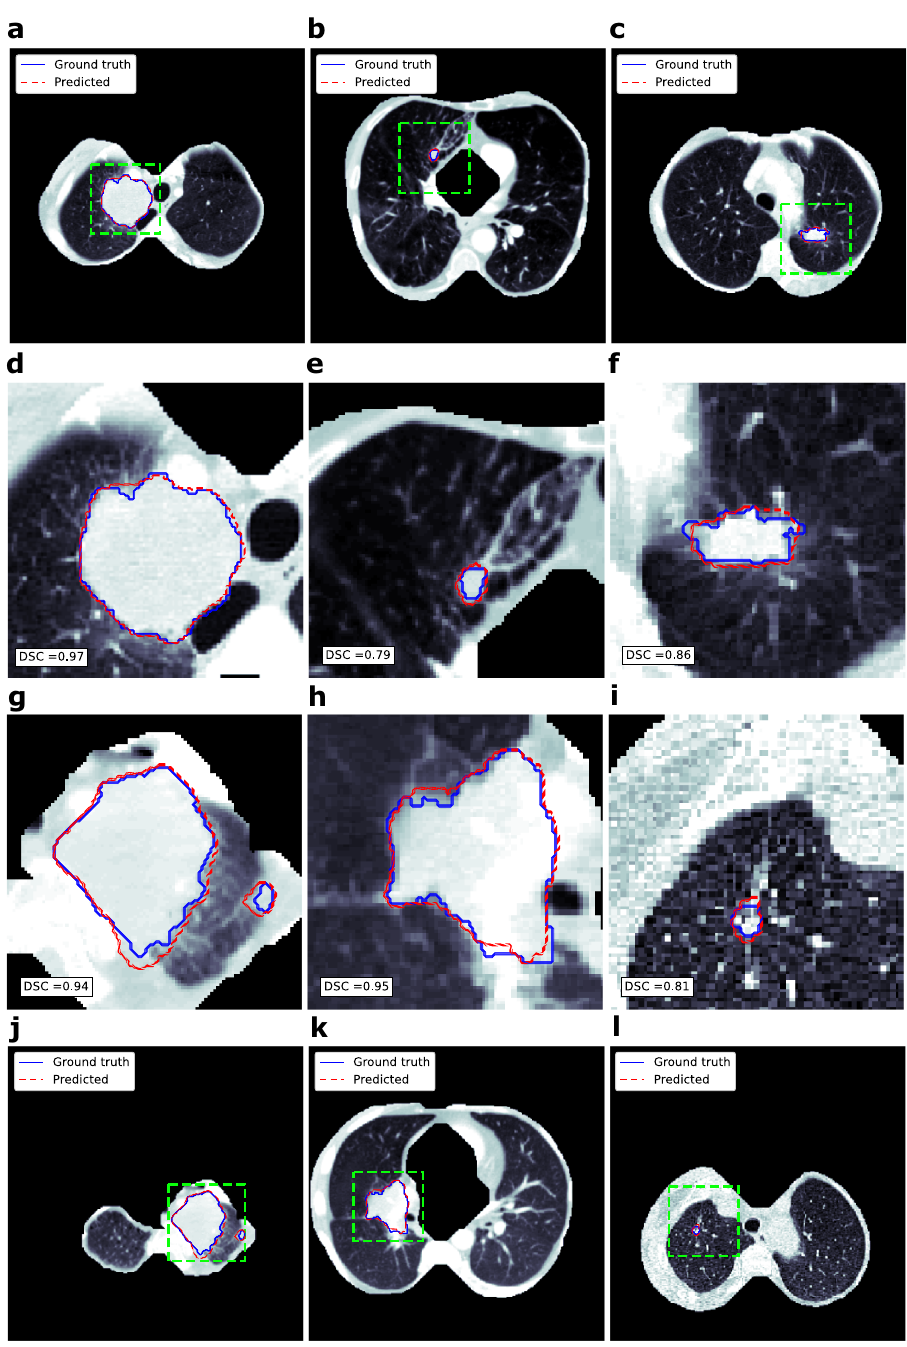
Fig. 3 Visualization of segmentations. Automatically generated tumor segmentations are shown as red lines while manual segmentations are shown in blue, the green dashed box shows the area to be magni fi ed for better visuals. d – i display magni fi ed area for the ( a – c , j – l ) respectively. Corresponding 2D dice similarity coef fi cient is provided in the bottom left corner on the ( d – i ).